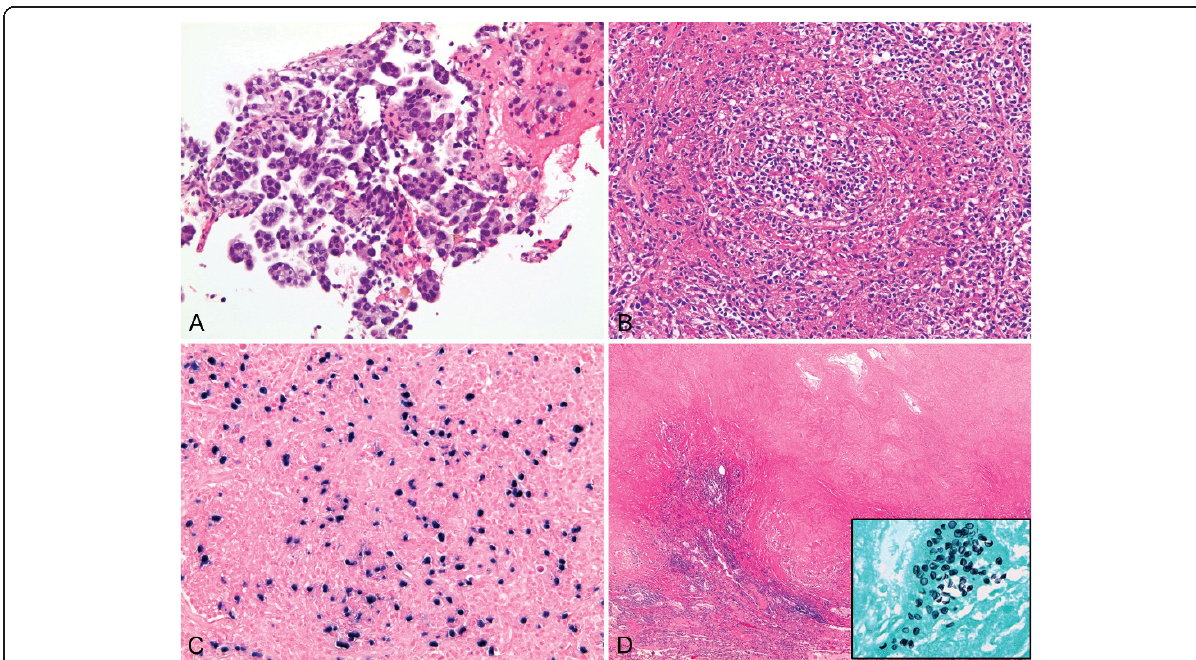
Figure 1 Neoplastic and non-neoplastic localized lesions in renal transplant recipients . (A) adenocarcinoma with predominantly micropapillary pattern (case 22, hematoxylin-eosin, original magnification x200); (B) lymphomatoid granulomatosis showing angiocentric proliferation of atypical lymphoid cells associated with Epstein-Bar virus (C), (case 25, hematoxylin-eosin and colorimetric in situ hybridization, original magnification x200 and x400, respectively); necrotizing granuloma (D) associated with Pneumocystis jiroveci (case 21, hematoxylin-eosin and Gomori methenamine silver, inset, original magnification x100 and x600,